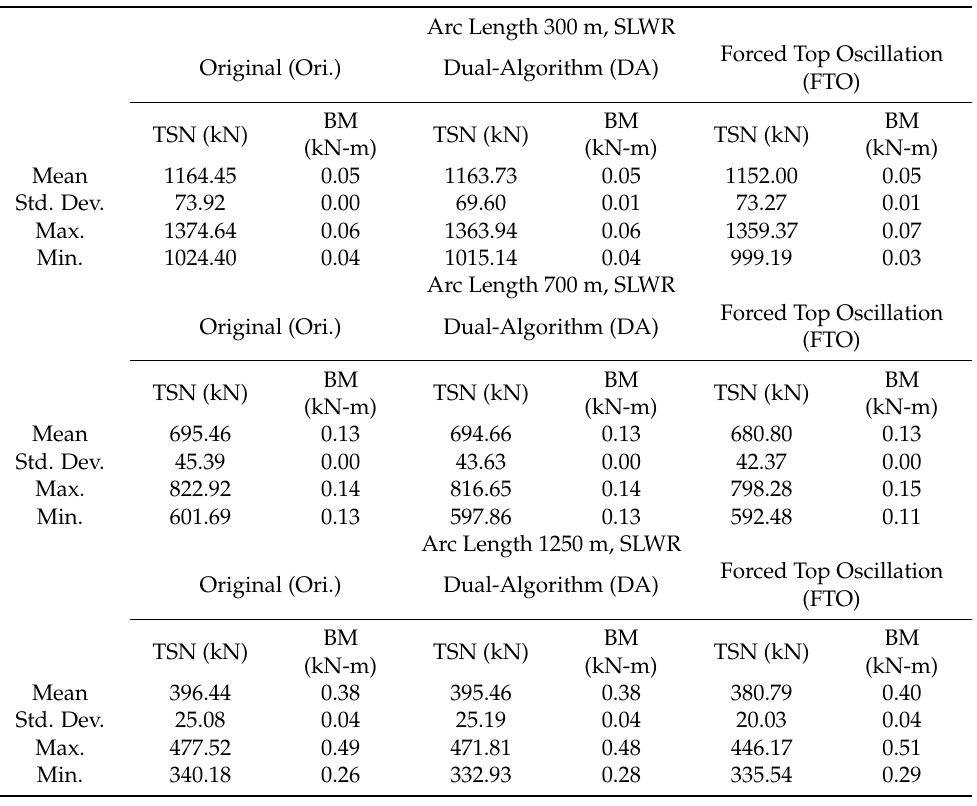
Table A3. Statistical Characteristics Comparison, Original vs. Dual-Algorithm (DA) or FTO, 100-yr storm, WD1000, SLWR.